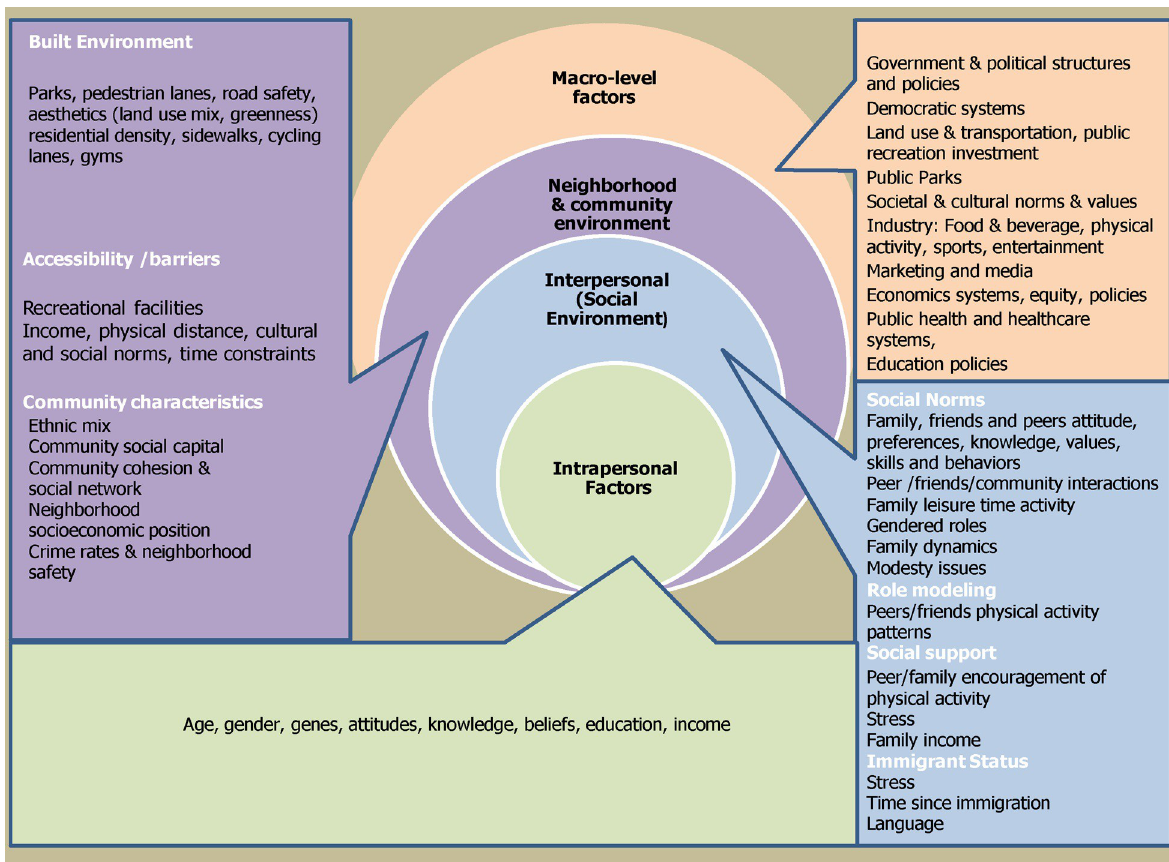
Fig 1. Social ecological model (Adapted from Storey , M and K . K Davison , 2008) .